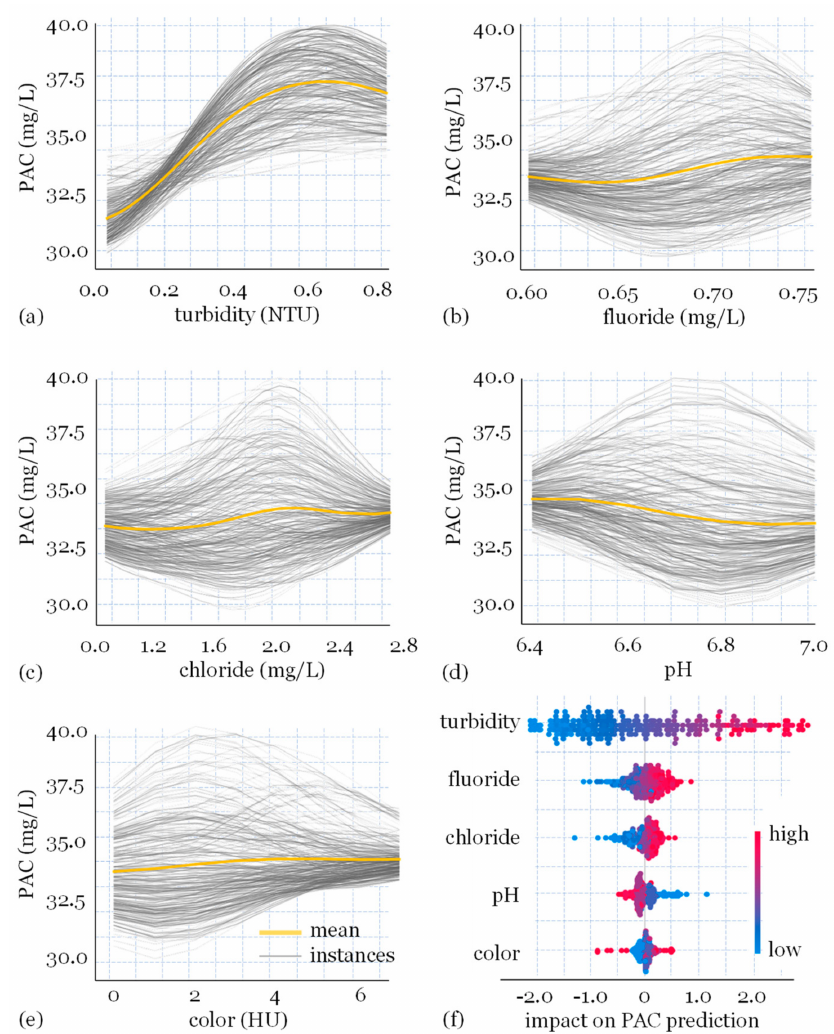
Figure 8. Individual conditional expectation and the impact of each water quality parameter on the D 2 FIS prediction: ( a ) PAC × turbidity; ( b ) PAC × fluoride; ( c ) PAC × chloride; ( d ) PAC × pH, ( e ) PAC × color; and ( f ) water quality parameters ×